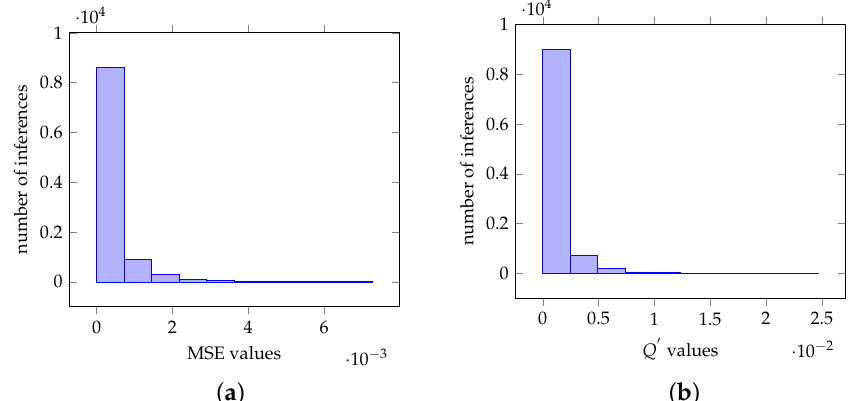
Figure 10. Values obtained from imagenet image MobileNetV2 net classification for 1000 classes. ( a ) Histogram of the MSE values. ( b ) Histogram of the Q (cid:48) values.